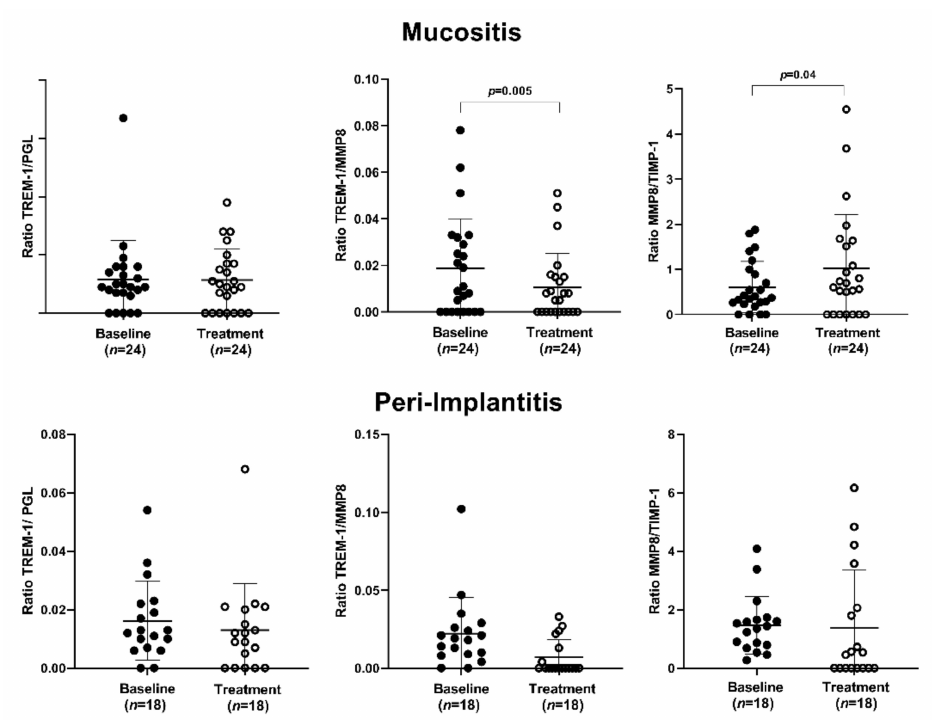
Figure 4. Peri-implant treatment effects on the ratio of total sTREM-1/PGLYRP-1, sTREM-1/MMP-8, and MMP-8/TIMP-1 in peri-implant mucositis patients and peri-implantitis patients before and after peri-implant treatment. p ≤ 0.05 (Wilcoxon signed-rank